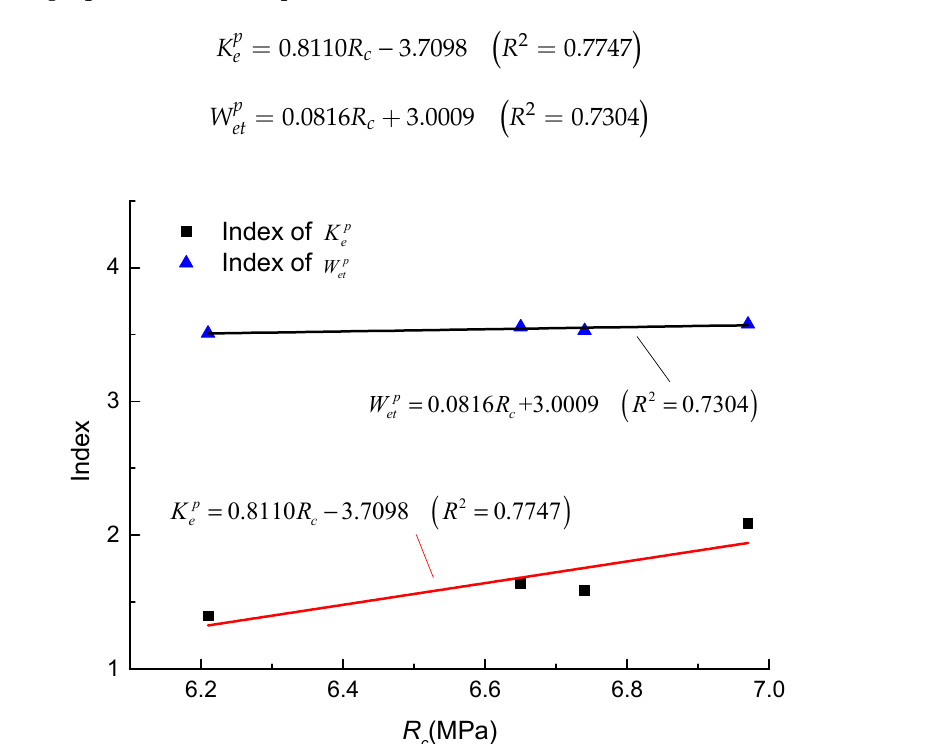
p p , and UCS in PJ coal e , W et